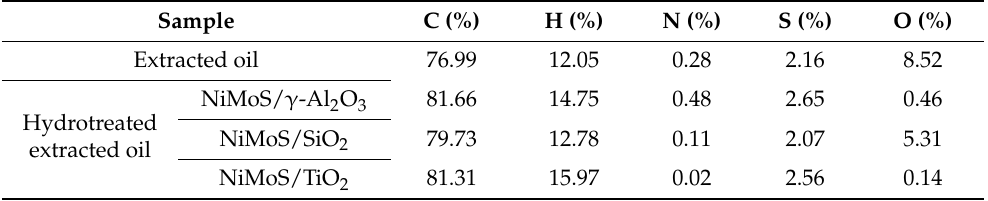
Table 2. The elemental analysis of the feedstocks and liquid products of supported sulfide NiMo over γ -Al 2 O 3 , SiO 2, and TiO 2 catalysts.